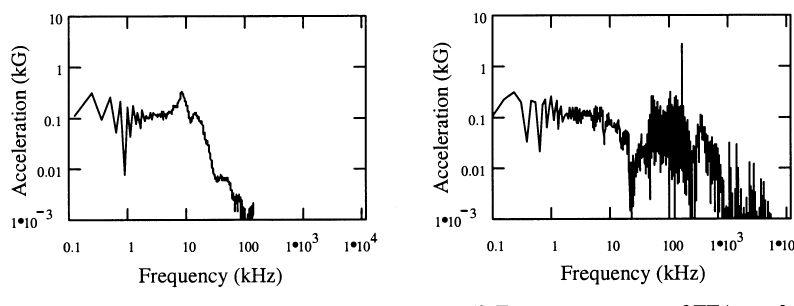
Fig. 3. Ball bearing impact example, experiment and /Explicit FEA